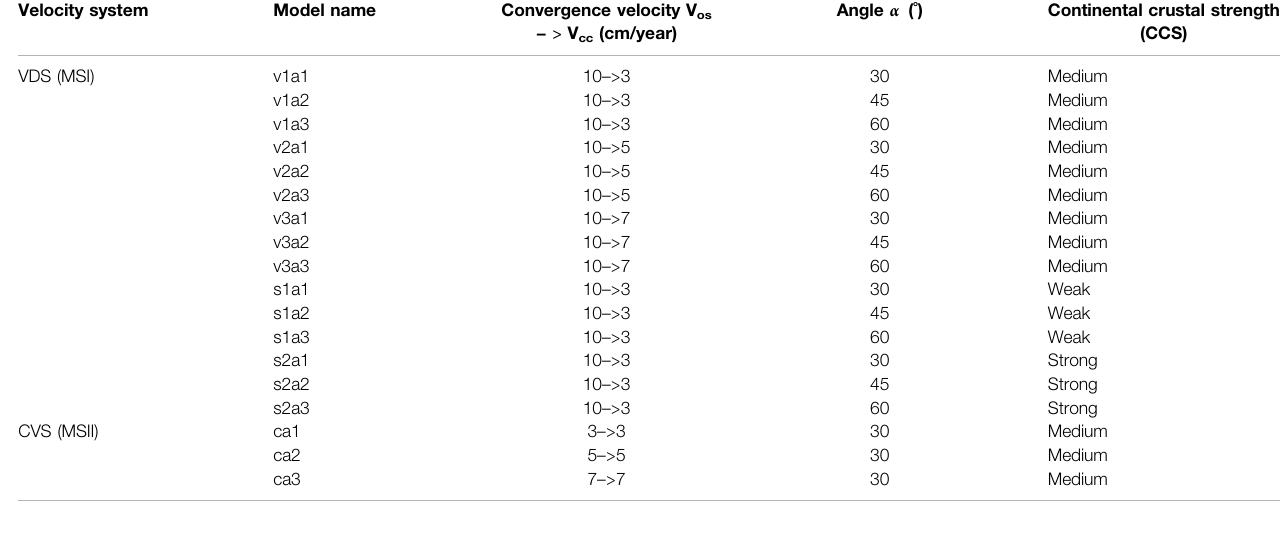
TABLE 3 | Model list of parametric tests.